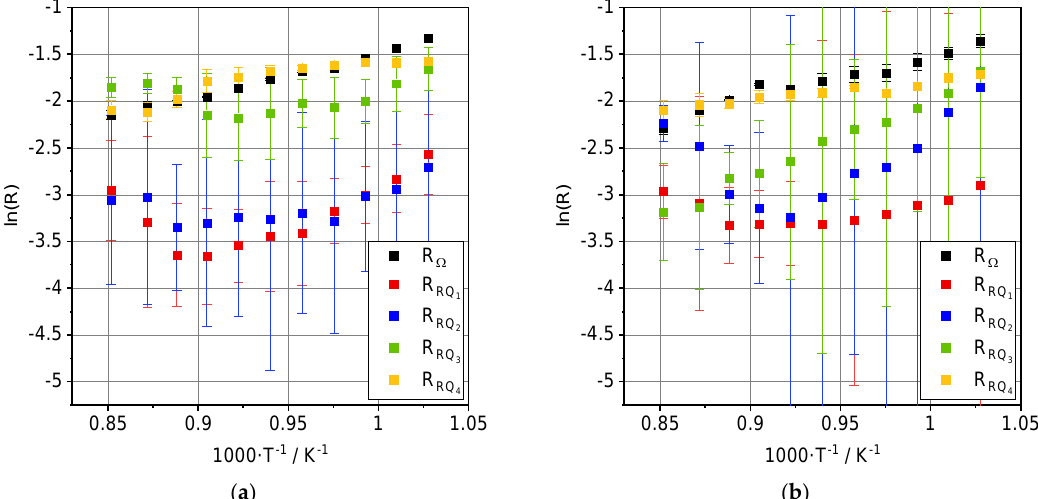
Figure 6. Arrhenius plot for the resistances for a ratio of CO 2 :CO of 80:20 at 6 L · h − 1 at ( a ) OCV and ( b ) 0.35 A · cm − 2 . Table 1. Activation energies for the resistances R Ω and R RQ1 to R RQ4 for a ratio of CO 2 :CO of 80:20. Process